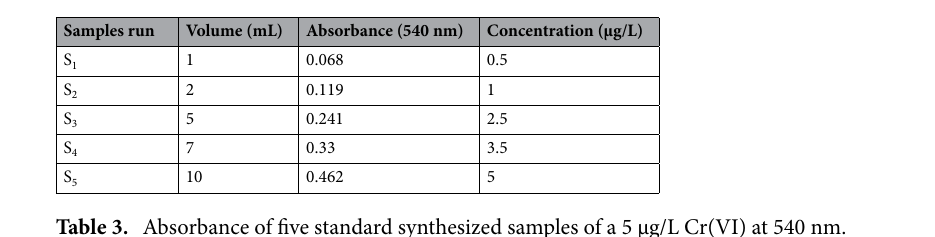
Table 3. Absorbance of five standard synthesized samples of a 5 µg/L Cr(VI) at 540 nm.